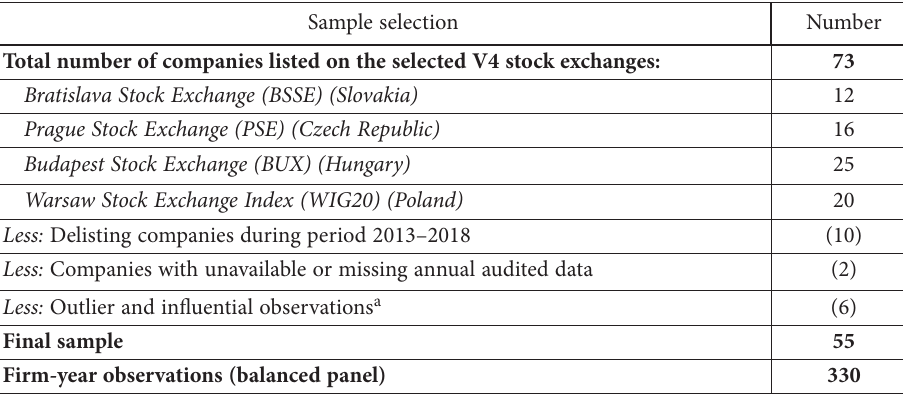
Table 2. Summary of sample